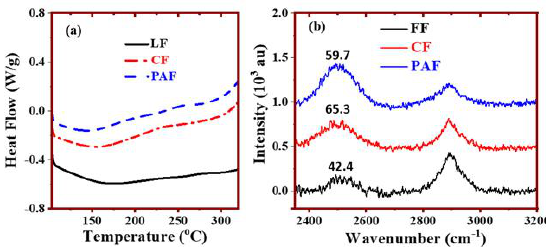
Figure 8. Differential scanning calorimetry ( a ) and Raman spectra ( b ) for Linen Fiber (LF) and its treated forms (CF: chlorite treatment; and PAF: peroxyacetic acid treatment).